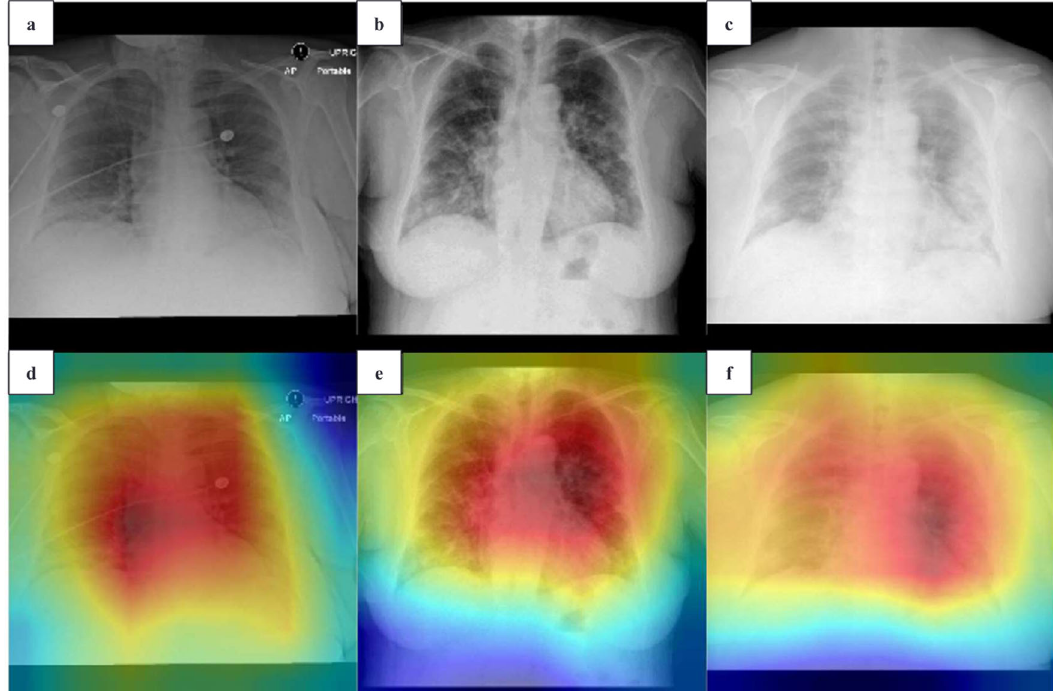
Fig. 2 COVID-19 diagnosis model gradient-weighted class activation mapping (Grad-CAM) visualization. All images were predicted correctly as COVID-19 positive. Grad-CAM heatmaps visualize which portions of the input chest radiograph were important for the classi fi cation decision. a Brown-April, original chest radiographs, b External, original chest radiographs, c Xiangya-February, original chest radiographs, d Brown-April, Grad-CAM overlay, e External, Grad-CAM overlay, and f Xiangya-February, Grad-CAM